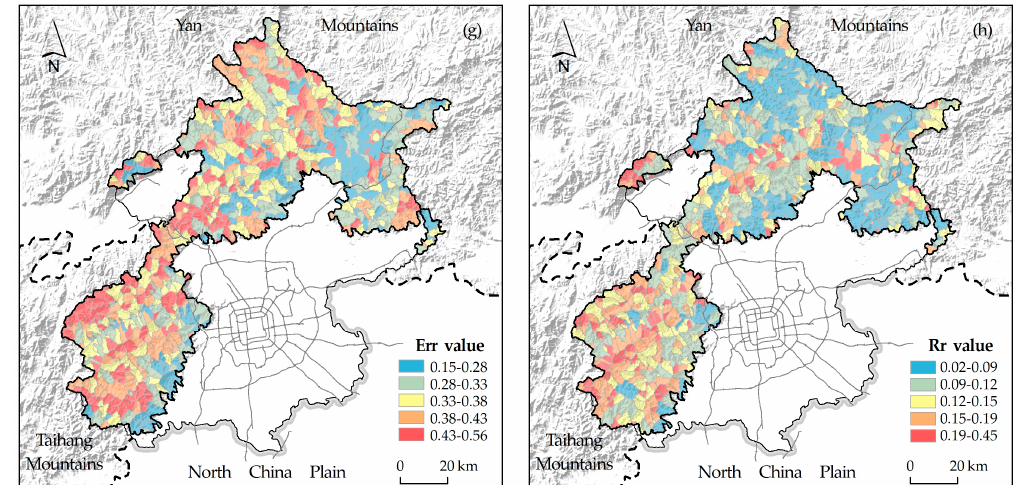
Figure 4. Numerical classes of parameters related to the catchment shape: ( a ) Cr; ( b ) Er; ( c ) Dd; ( d ) Ff; Numerical classes of parameters related to the relief gradient: ( e ) RI; ( f ) Mr; ( g ) Err; ( h ) Rr.